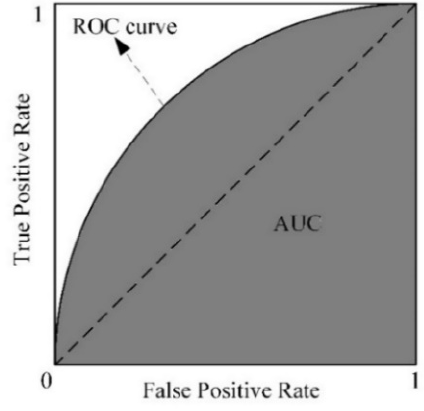
Figure 5. ROC curve and AUC